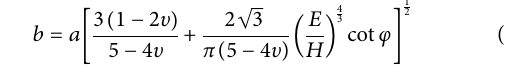
Figure 6. The stress fi eld in the scratch groove includes the Boussinesq fi eld, Cerruti fi eld, and sliding blister fi eld. Therefore, the stress components in the scratching zones are expressed as Eq. 2 (Jing et al., 2007).